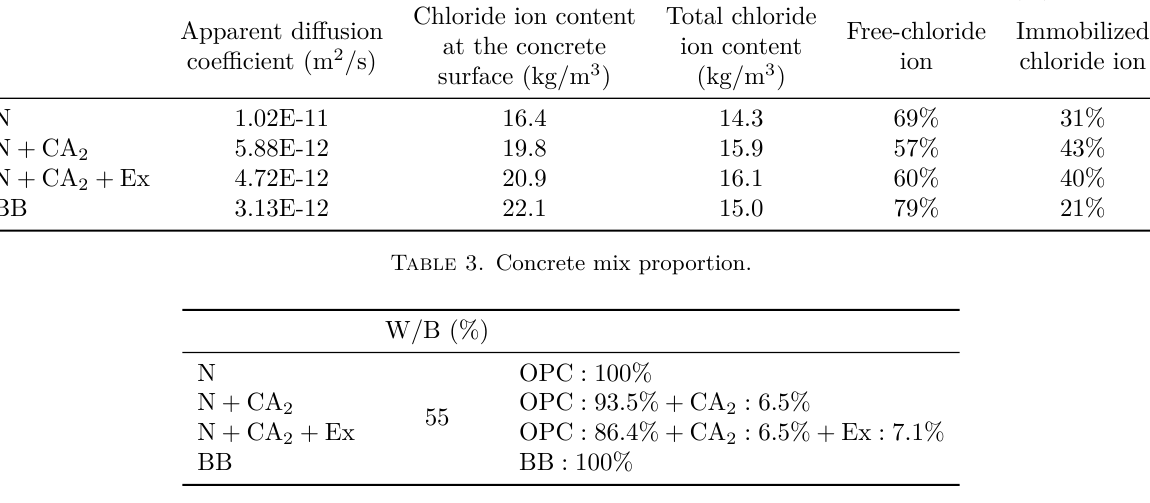
Table 4. Mix proportions of the pastes.